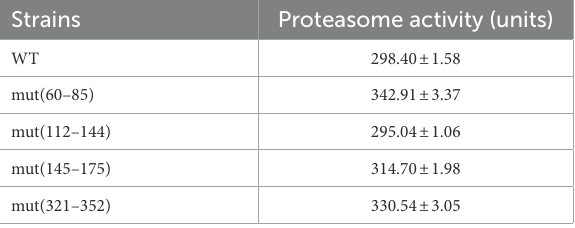
TABLE 4 Proteasome